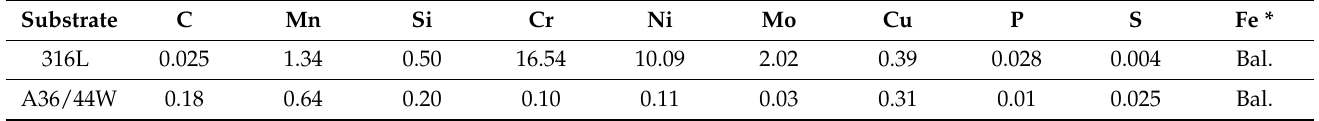
Table 1. Chemical composition of steels selected in the work